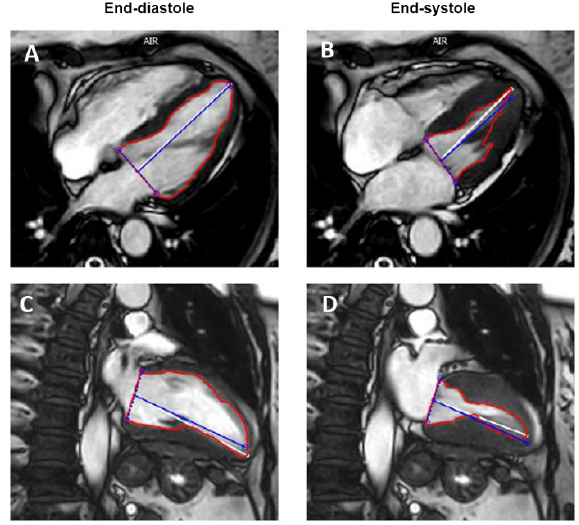
Figure 4. Cardiac magnetic resonance calculation of left ventricular ejection fraction using cine 4-chamber long axis ( A , B ) and 2-chamber long-axis ( C , D ) images.